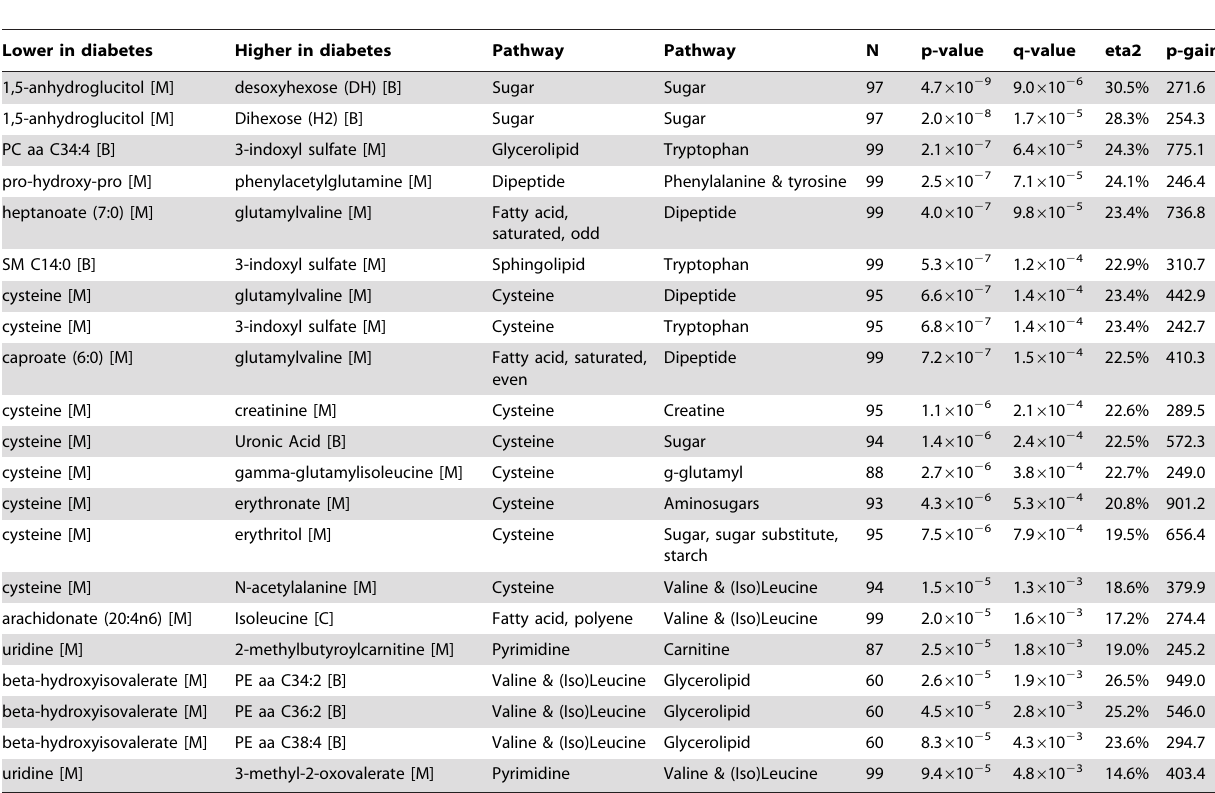
Table 3. List of selected metabolite concentration ratios that associate with diabetes at q-values , 0.05 and that display a significant increase in the strength of association (p-gain . 241) after Bonferroni correction; based on log-scaled metabolite concentration ratios and assuming a linear model.